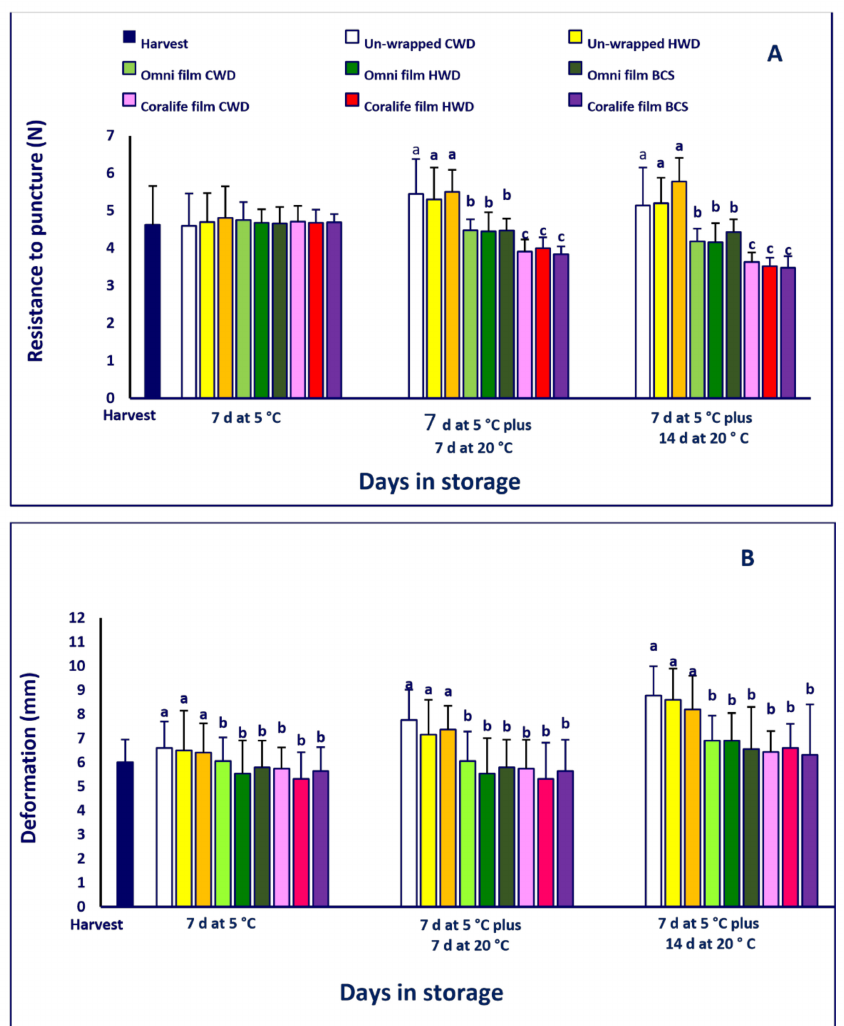
Figure 4. Changes in Resistance to puncture ( A ) and deformation ( B ) mness in ‘Simeto’, as affected by fungicidal treatments and packaging. For each storage period, means followed by different letters are significantly different at p ≤ 0.05. Means separation was accomplished by Duncan’s multiple range test. Vertical bars are the standard deviations of (n =